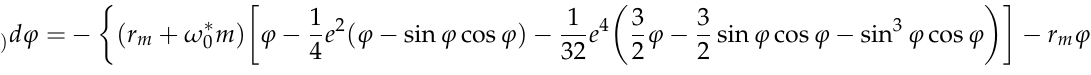
where e indicates the eccentricity of the ellipse, which can be expressed as follows: